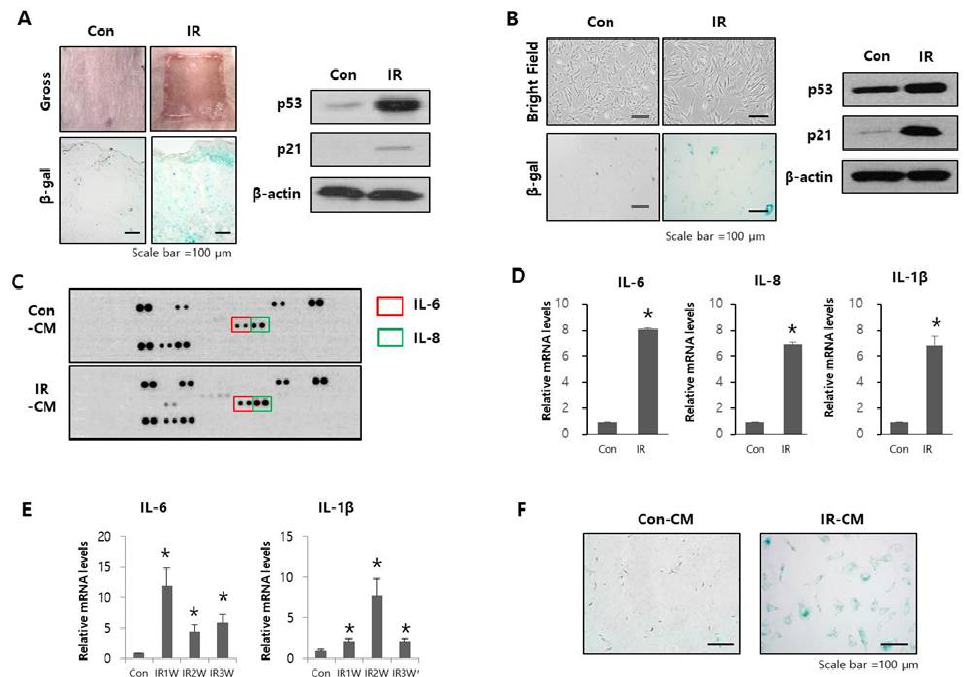
Figure 1. The effects of radiation-induced SASP on adjacent cells and radiation ulcers. ( A ) Representative gross and SA- β -gal staining images ( left ), as well as p53 and p21 expression levels ( right ), in mouse skin 10 days after radiation exposure. Three mice per group were used. ( B ) Representative cell morphological and SA- β -gal staining images ( left ), as well as p53 and p21 expression levels ( right ), in HDFs after radiation exposure. ( C ) Cytokine screening in conditioned medium from control HDFs (Con-CM) and conditioned medium from irradiated HDF (IR-CM). ( D ) mRNA levels of IL-6, IL-8, and IL-1 β in HDFs after radiation exposure. Data are presented as mean ± standard deviation with statistical significance set at * p < 0.05 vs. control group (Con). ( E ) mRNA levels of IL-6 and IL-1 β in mouse skin after radiation exposure. Data are presented as mean ± standard error, with statistical significance set at * p < 0.05 vs. control group (Con). Six mice per group were used. ( F ) Representative SA- β -gal staining images in HDFs cultured in Con-CM and IR-CM for 3 days.